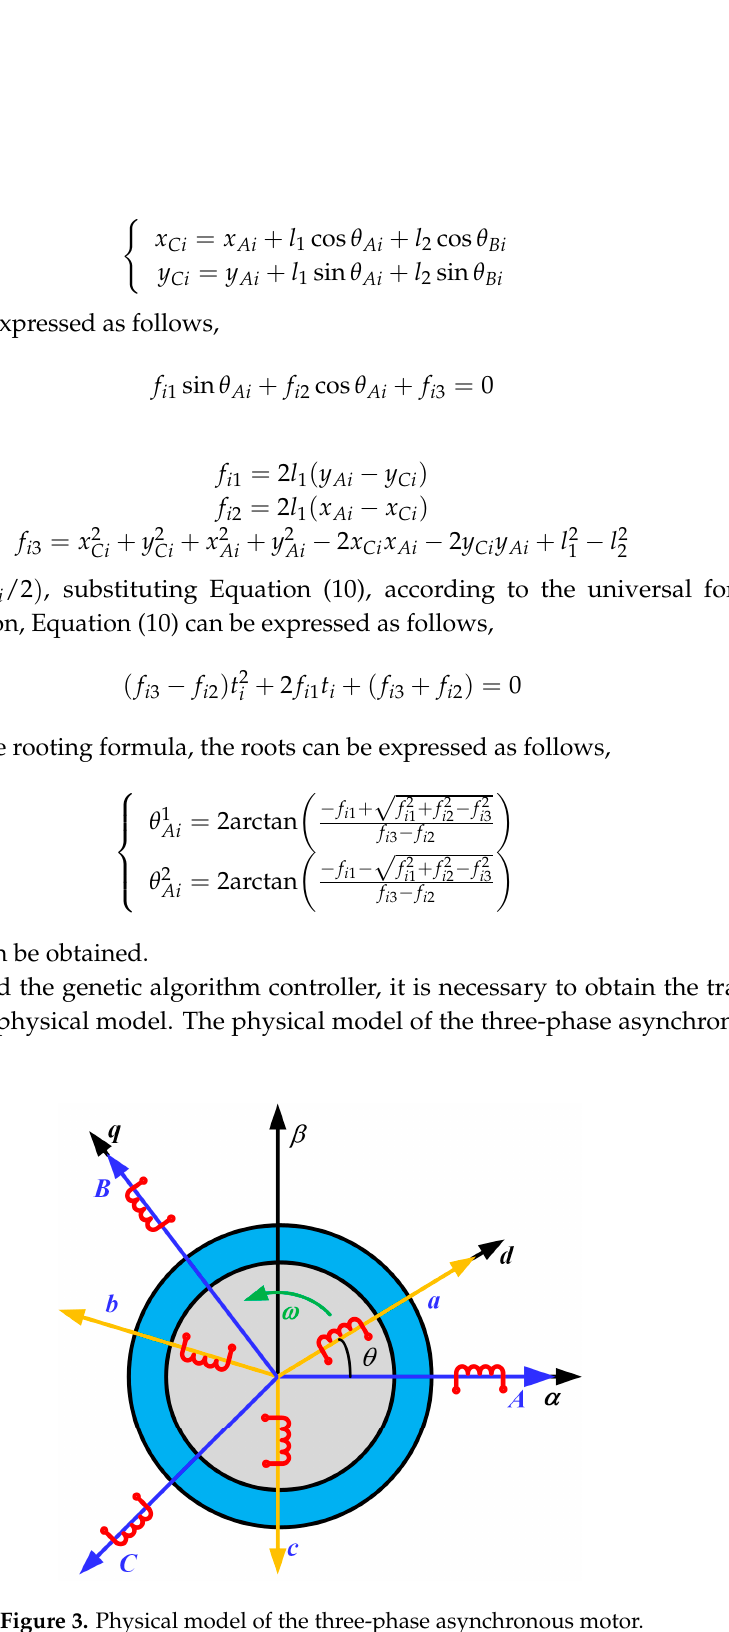
Figure 3. Physical model of the three-phase asynchronous motor.